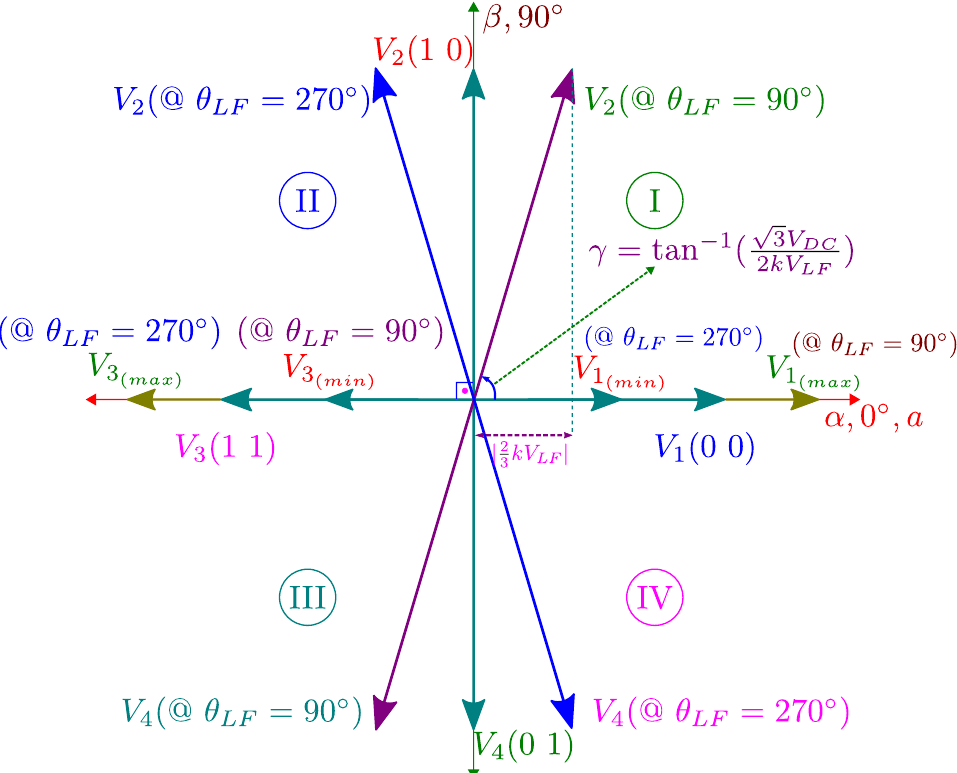
Figure 2. Non-zero voltage vectors of the FSTP VSI under low-frequency signal injection (LFSI) applied to the d -axis synchronous reference